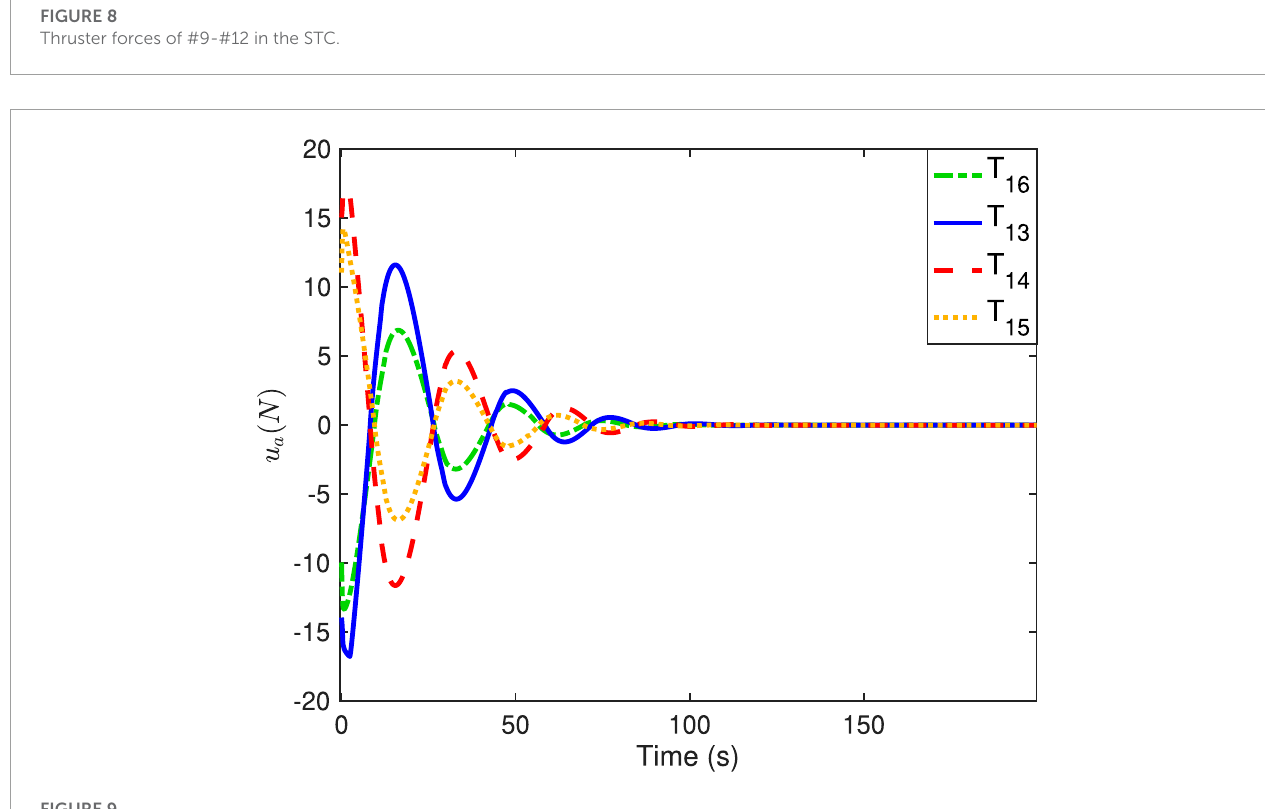
FIGURE 9 Thruster forces of #13-#16 in the STC.